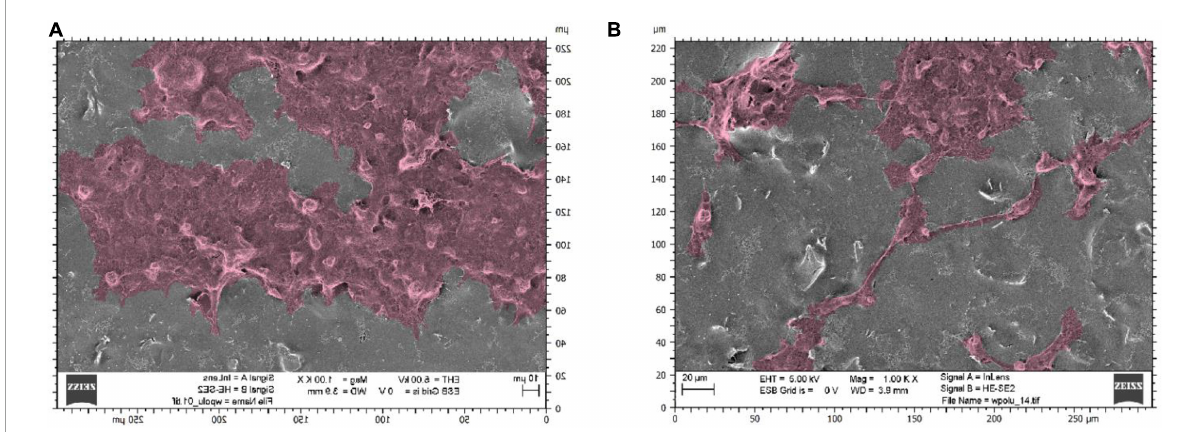
FIGURE7 Scanning electron microscope photographs showing neural stem cells on graphene layers stimulated with a voltage of 5 V amplitude: substrates made with sonicated inks using (A) sonotrode (B) ultrasonic bath.